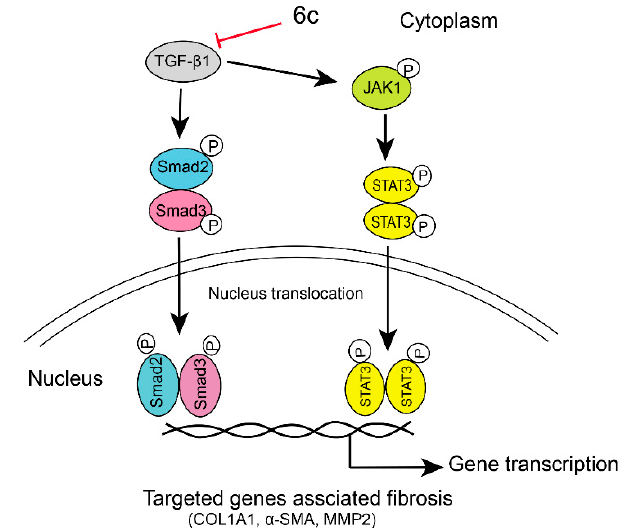
Figure 6. 6c repressed liver fibrogenesis via repressing TGF- β 1 / Smads and JAK1 / STAT3 pathways.